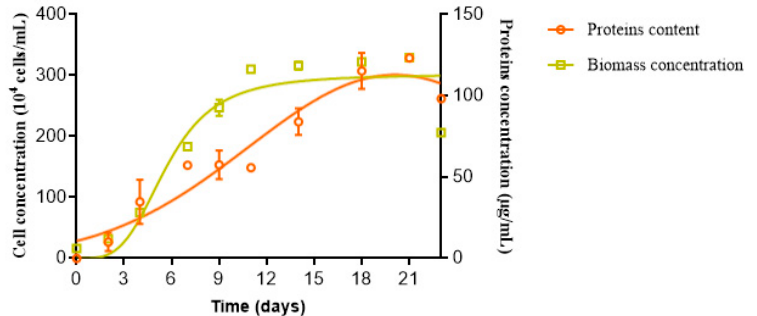
Figure 1. Assessment of Rhodomonas sp. cell density and protein production in accordance with growth